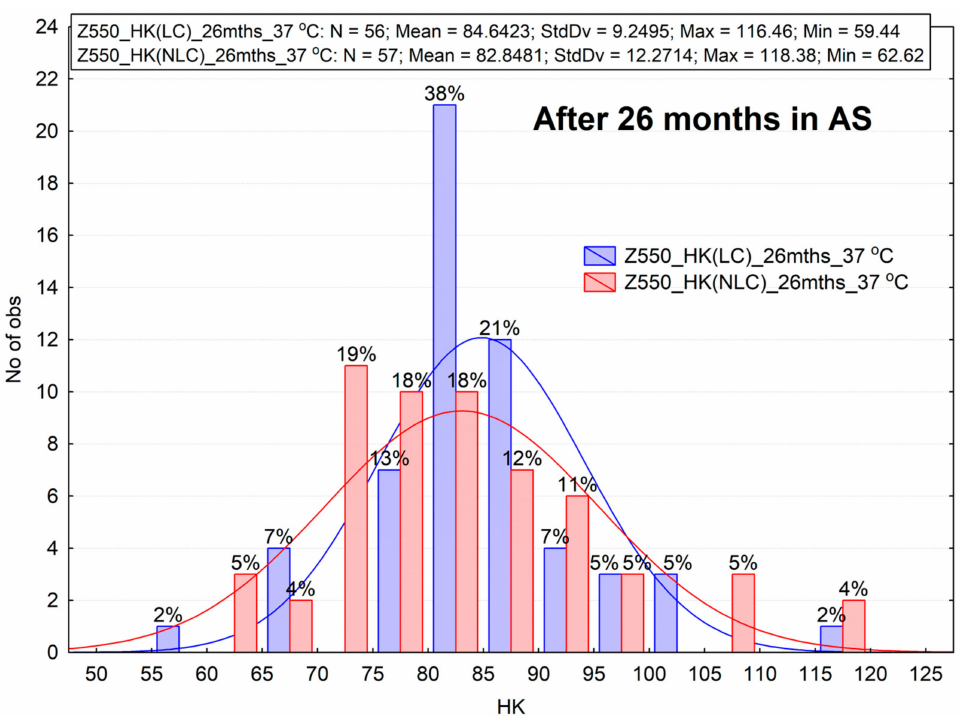
Figure 7. The results of Knoop hardness measurements for Z550 after aging in artificial saliva (AS) for 26 months. LC—light-cured surface of sample (the top side of a sample), NLC—non-light-cured surface (the bottom side of a sample), HK—Knoop hardness.